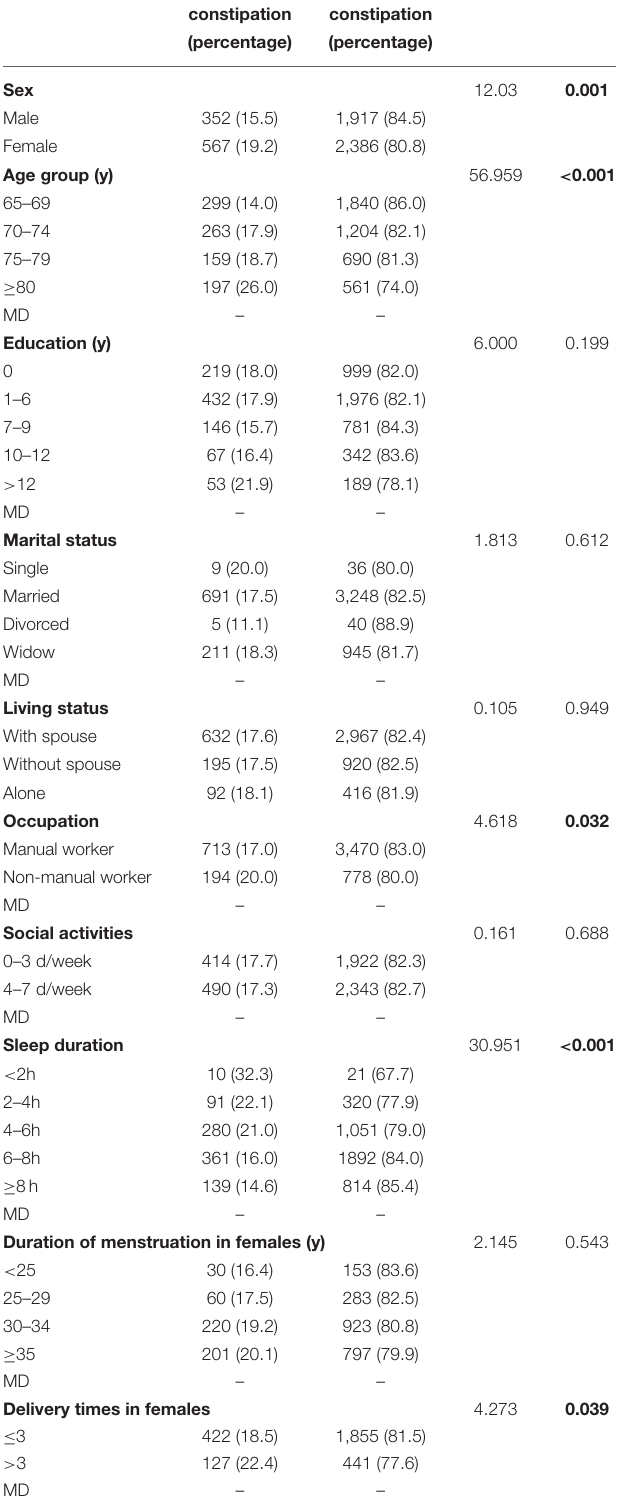
TABLE 2 | Comparison of the prevalence of constipation between different groups. Group With Without χ 2